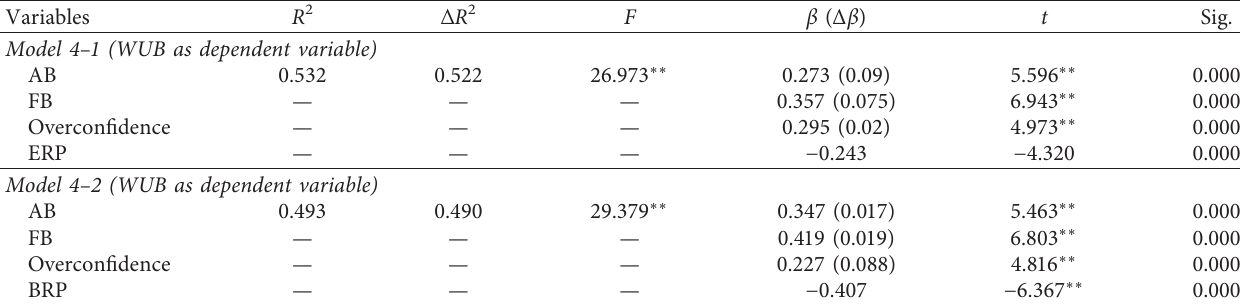
Table 6: Statistical results of two models for mediating